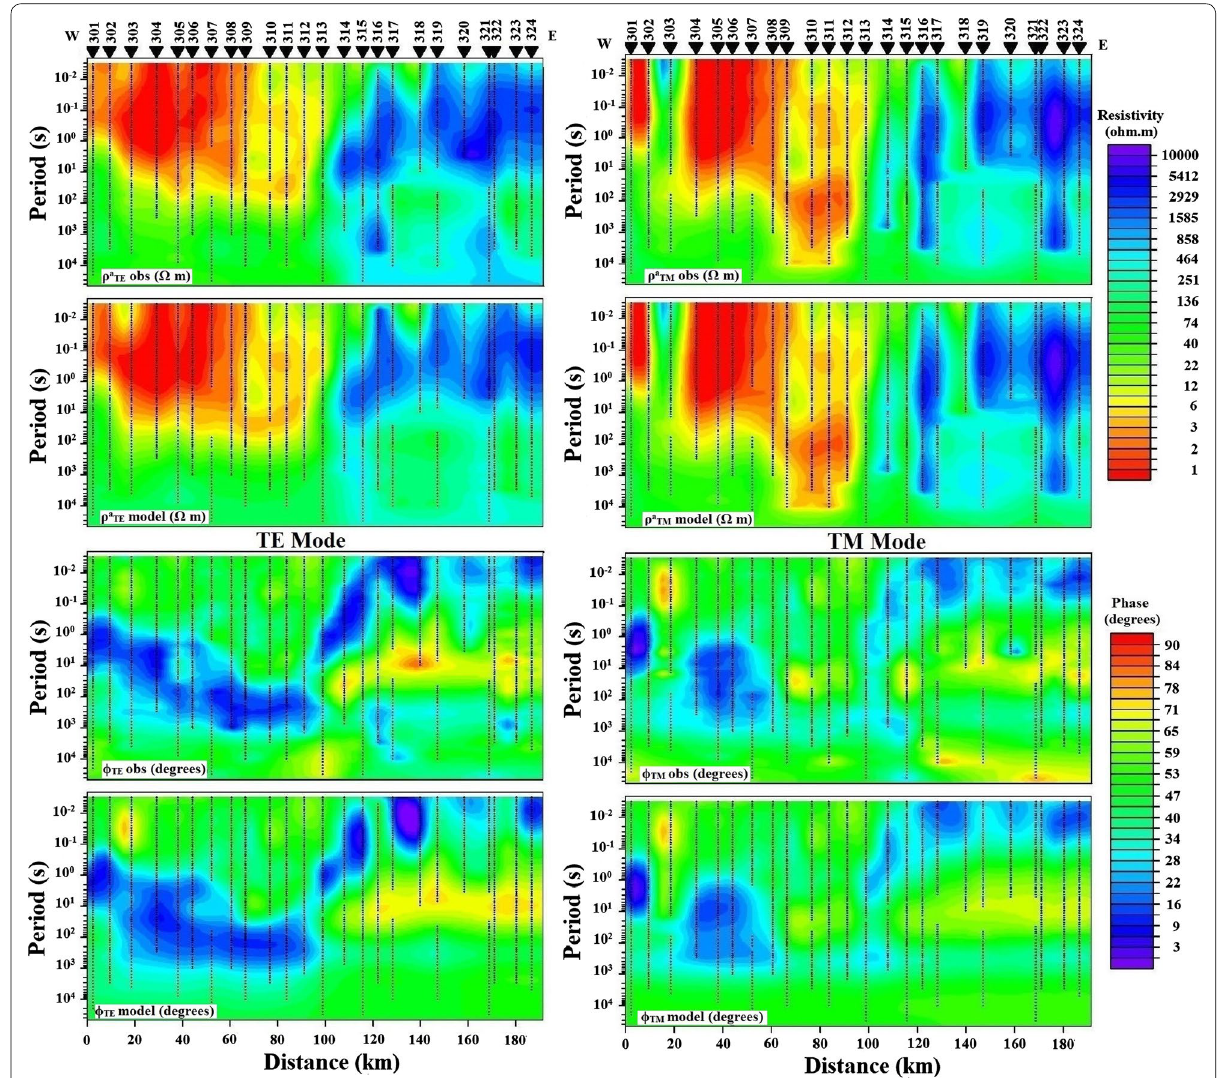
Fig. 7 Observed (Groom–Bailey decomposed) and modeled apparent resistivity and phase pseudo-sections in the transverse electric (TE) and transverse magnetic (TM) modes. The dots over the pseudo-sections at each site position and period correspond to the observed data points. Triangles indicate the location of the sites from west to